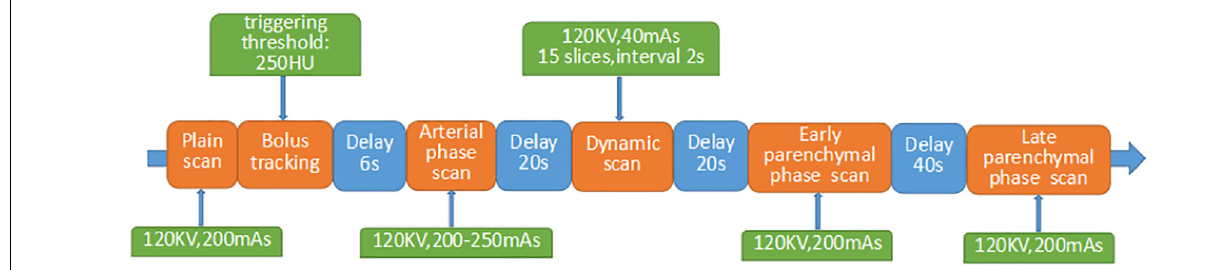
FIGURE 1 | Flowchart of a modified multiphasic CT scan protocol.